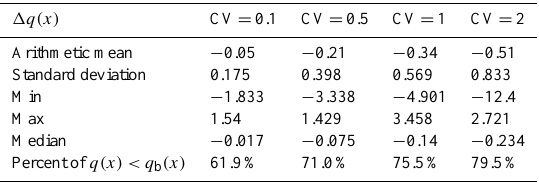
Table 2. Groundwater flow field statistics with local